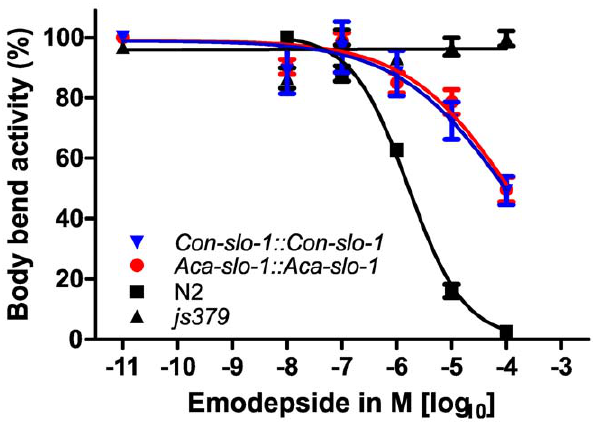
Figure 4. Parasite SLO-1 expressed from parasite-derived slo-1 promoters partially recover emodepside susceptibility in resistant slo-1 loss-of-function mutants. Body bend activity (relative to the highest number of body bends in each group) of young adults after 24 h exposure to emodepside. Comparison of wild- N type N2, emodepside-resistant strain slo-1(js379) , and transformed slo- ) represent Aca-slo-1::Aca-slo-1 lines (expressing A. 1(js379) lines. Dots ( caninum slo-1 from the putative A. caninum slo-1 promoter); inverted triangles ( . ) Con-slo-1::Con-slo-1 lines (expressing C. oncophora slo-1 from the putative C. oncophora slo-1 promoter); squares ( & ) N2 Bristol wild-type strain, triangles ( m ) js379(slo-1) mutant strain.